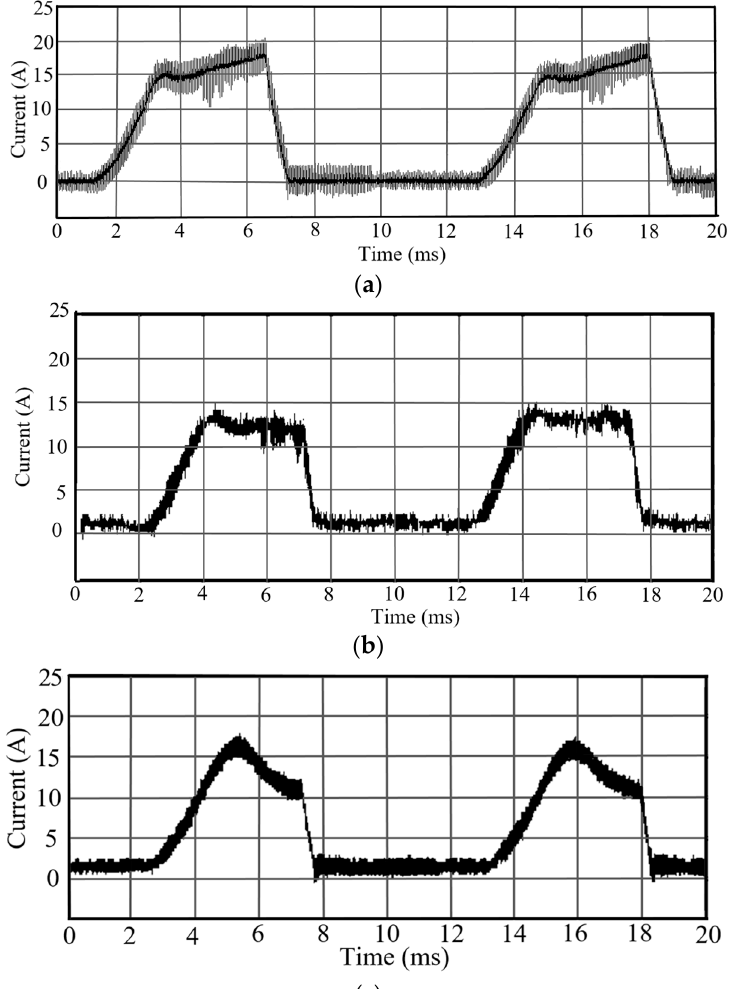
Energies 2022 , 15 , 5782 20 of 25